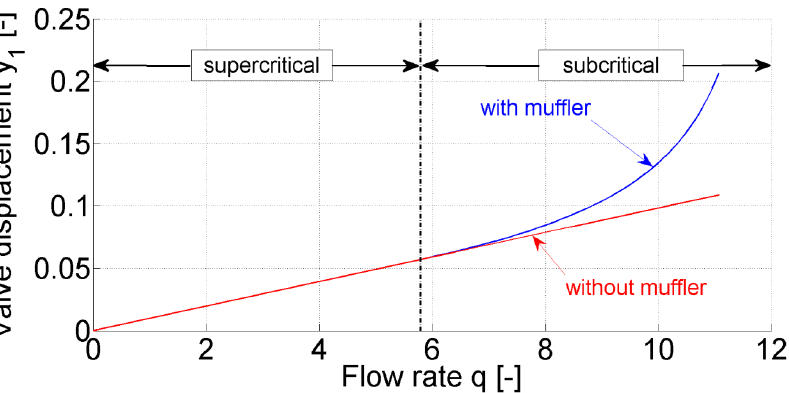
Figure 2. Steady state characteristic of the regulator: the valve displacement y 1 as a function of the flow rate q [13].